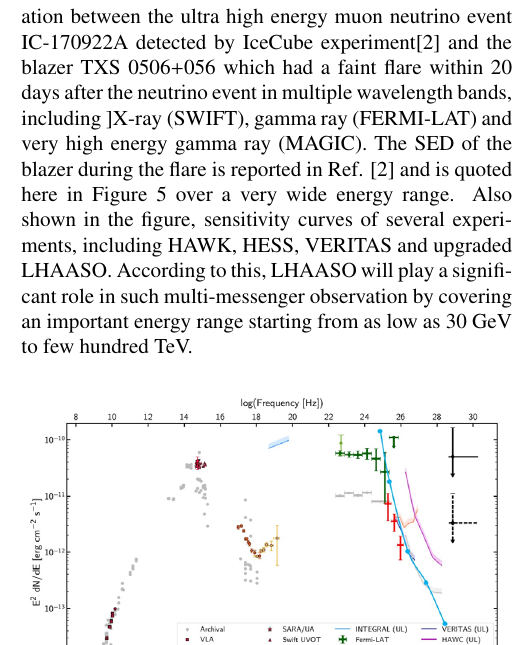
Figure 4. The di ff erential sensitivity of LHAASO (in red) com- paring with other experiments. Below 300 GeV, both estimates with 8" PMT configuration (dashed line) and 20" PMT configu- ration (solid line) are plotted. It is noticed that WCDA with 20" PMTs is almost as same sensitive as FERMI / LAT at 70 GeV.